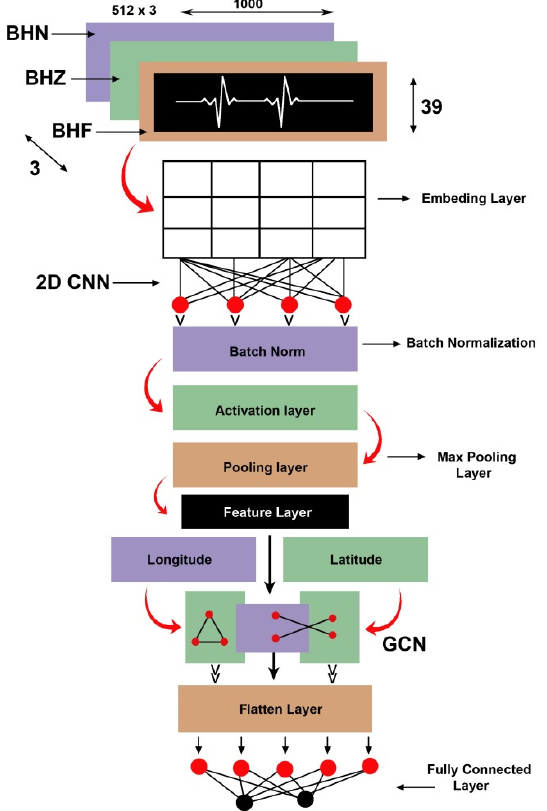
Figure 2. The proposed architecture of the batch normalization graph convolutional neural network. 3-channel data are fed into the model. Features are extracted by CNN and batch normalization is applied before pooling operation. Location information is added to the feature vector and the GNN part makes the final prediction.